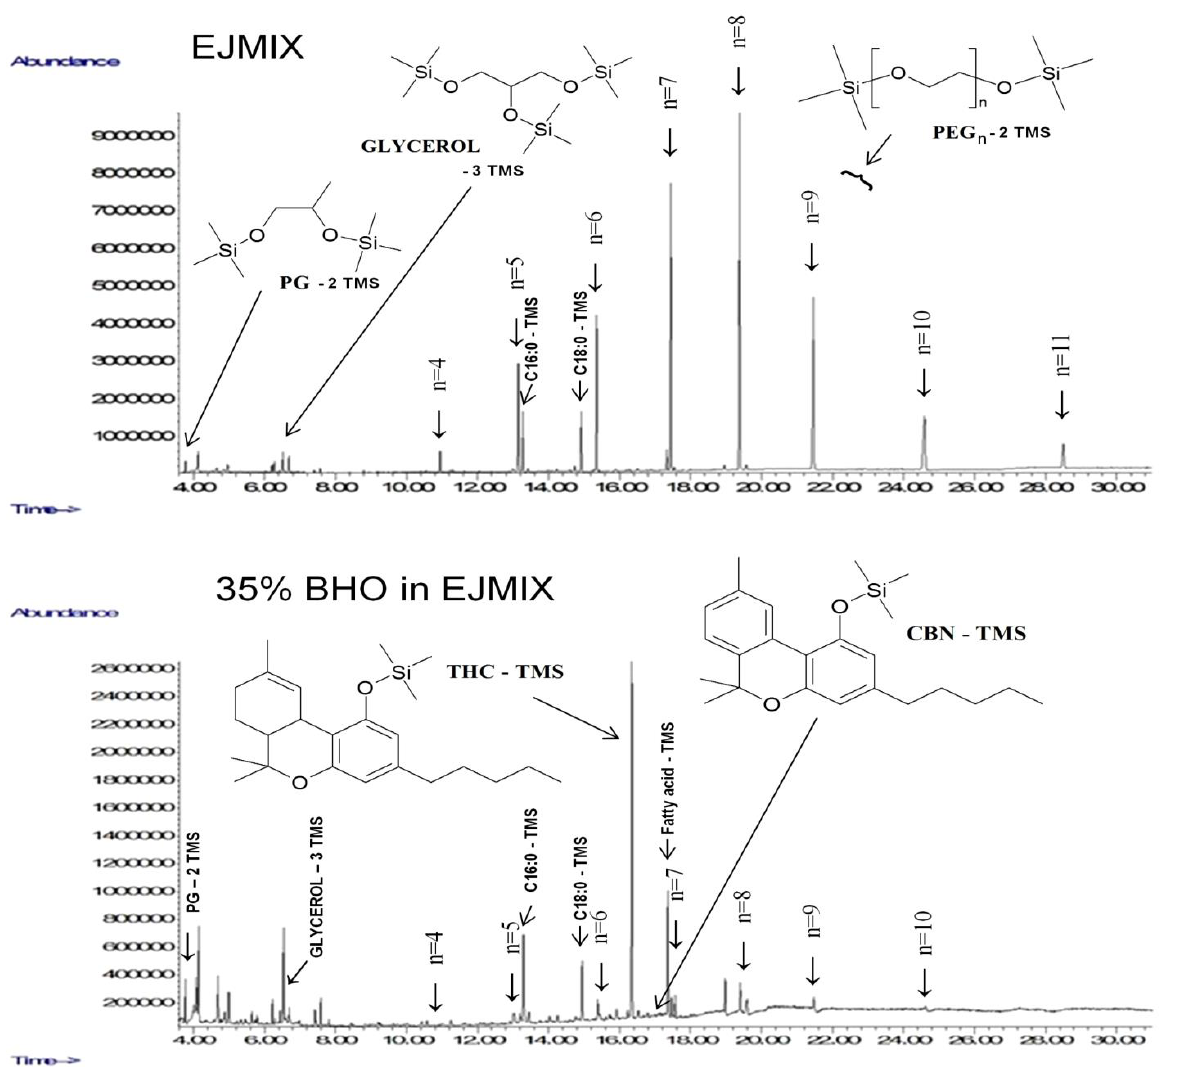
Figure 4. Gas chromatography-mass spectrometry (GC-MS) chromatograms of TMS derivatives of an EJMIX extract and of a BHO/EJMIX 35:65 w/w solution. EJMIX is a commercially available mixture of propylene glycol (PG) and polyethylene glycol (PEG) molecules in unknown proportions (Bloomsdays, USA). The PEG molecules are characterized by their number, n, of “oxyethylene” units. PEG 200 usually contains 4–5 units; PEG 300, 6–7 units; and PEG 400, 8–9 units. PG is propylene glycol or 1,2-propane diol. THC = (−)- trans -delta-9-tetrahydrocannabinol; CBN = cannabinol. C16:0 and C18:0 are palmitic and stearic acids,